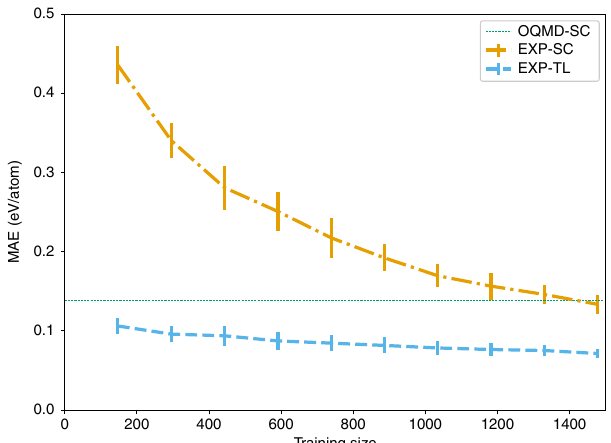
Fig. 3 Impact of training size on model performance. The models are trained on the experimental data set and the results are aggregated from a 10-fold cross-validation (mean and standard deviation). First, we split the complete data set randomly into training and test (validation) set in the ratio of 9:1. Next, we fi xed the test (validation) set and changed the size of the training set from 10 % to 100 % . OQMD-SC represents the model trained from scratch on OQMD data set, EXP-SC represents the model trained from scratch on the experimental data set, and EXP-TL represents the model built on experimental data set using transfer learning from the OQMD-SC